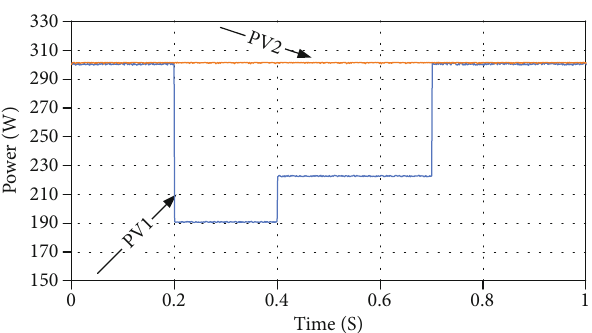
Figure 39: The output current of PV2.